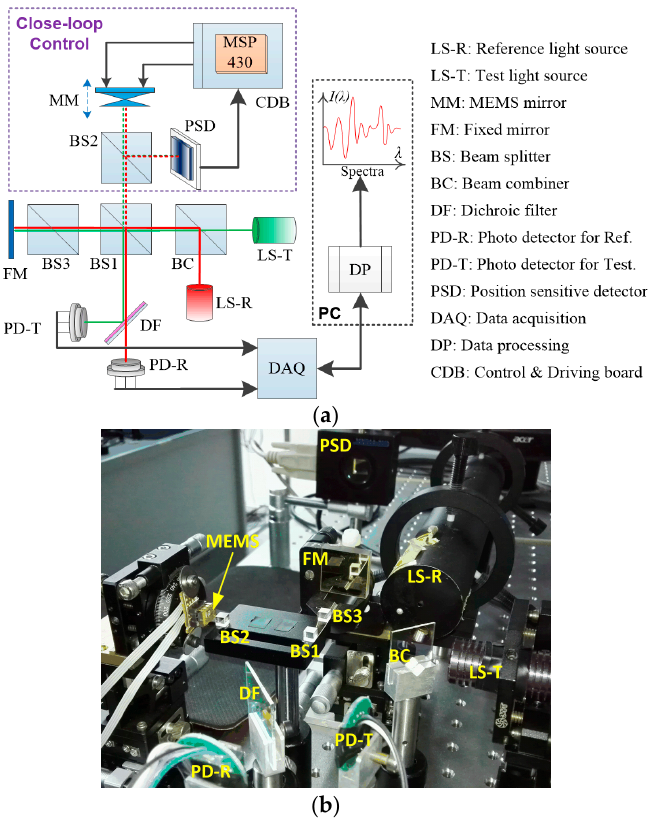
Figure 8. ( a ) The schematic of the FTS system with closed-loop control; ( b ) The experimental setup for